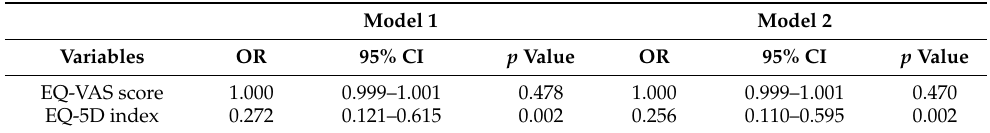
Table 4. Multivariate-adjusted ORs (95% CIs) for health-related quality of life in spine OA compared to